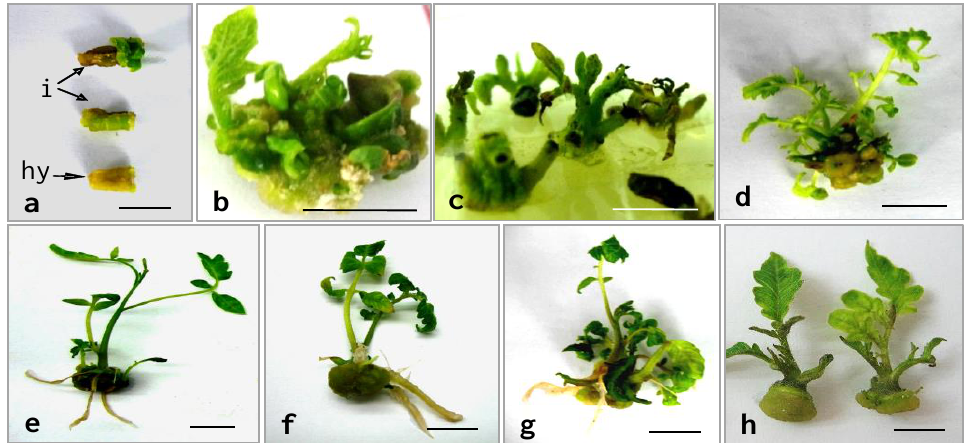
Figure 4. Morphogenic response of various explant types after 45 days in culture. ( a ) internodes (i) and hypocotyl (hy) (cv. ‘Kristin’); ( b ) leaf explant (cv. ‘Kristin’); ( c ) cotyledonary nodes (cv. ‘Kristin’); ( d ) stem nodes (cv. ‘Kristin’); ( e – g ) stem nodes (cvs. ‘Capriciu’, ‘Darsirius’ and ‘Pontica’); ( h ) apical buds (cv. ‘Siriana’). Explants were grown on MS with 1.5 mg L −1 Z + 0.2 mg L −1 IBA. Size bars = 1.0 cm.